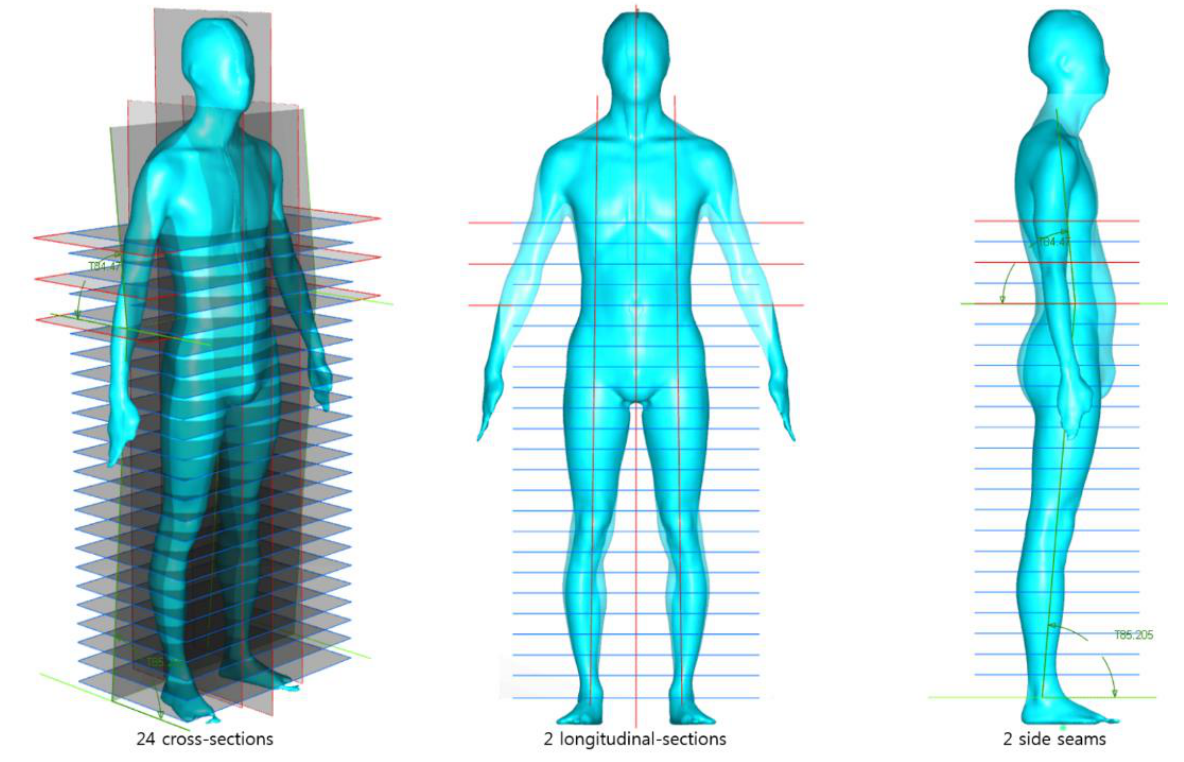
Figure 5. Reference plane for section analysis.